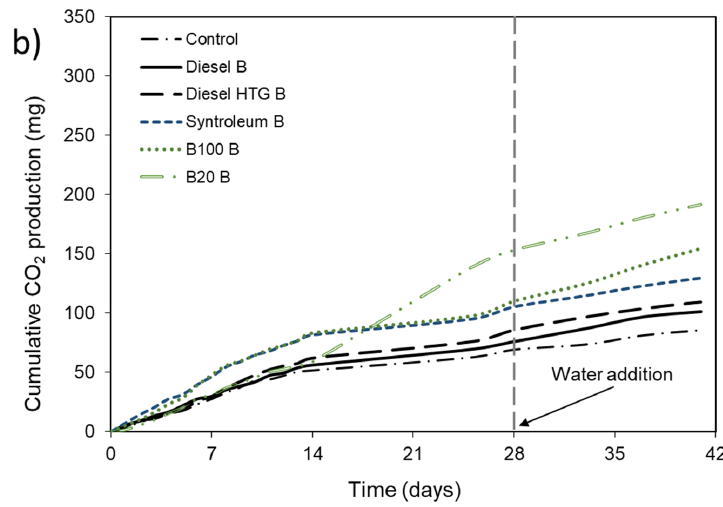
Figure 4. Cumulative fungal CO 2 production based on volatile compounds for different fuel types.